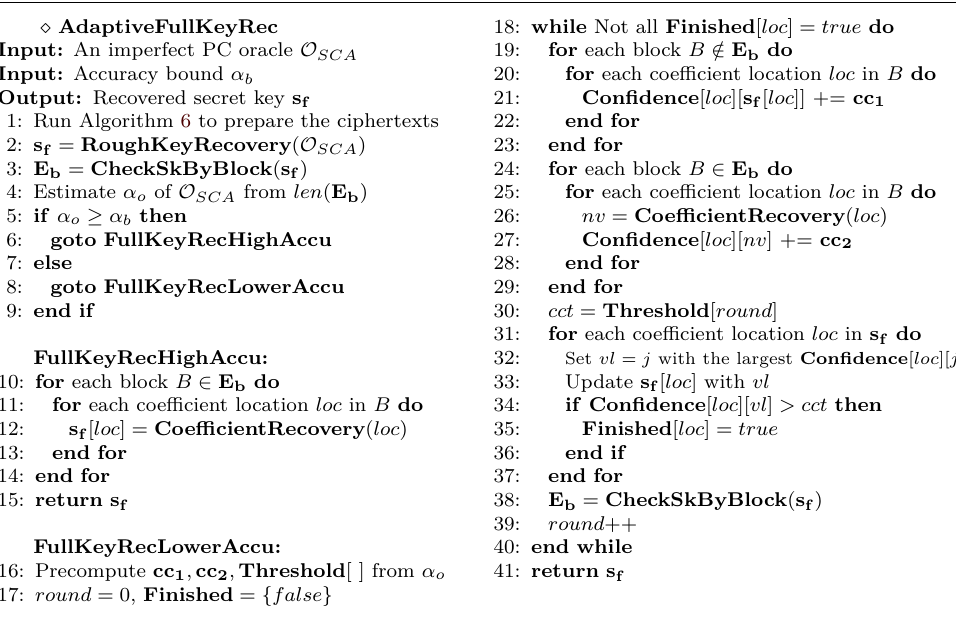
Algorithm 7 Our Adaptive Full-Key Recovery Strategy for Different Accuracy Level